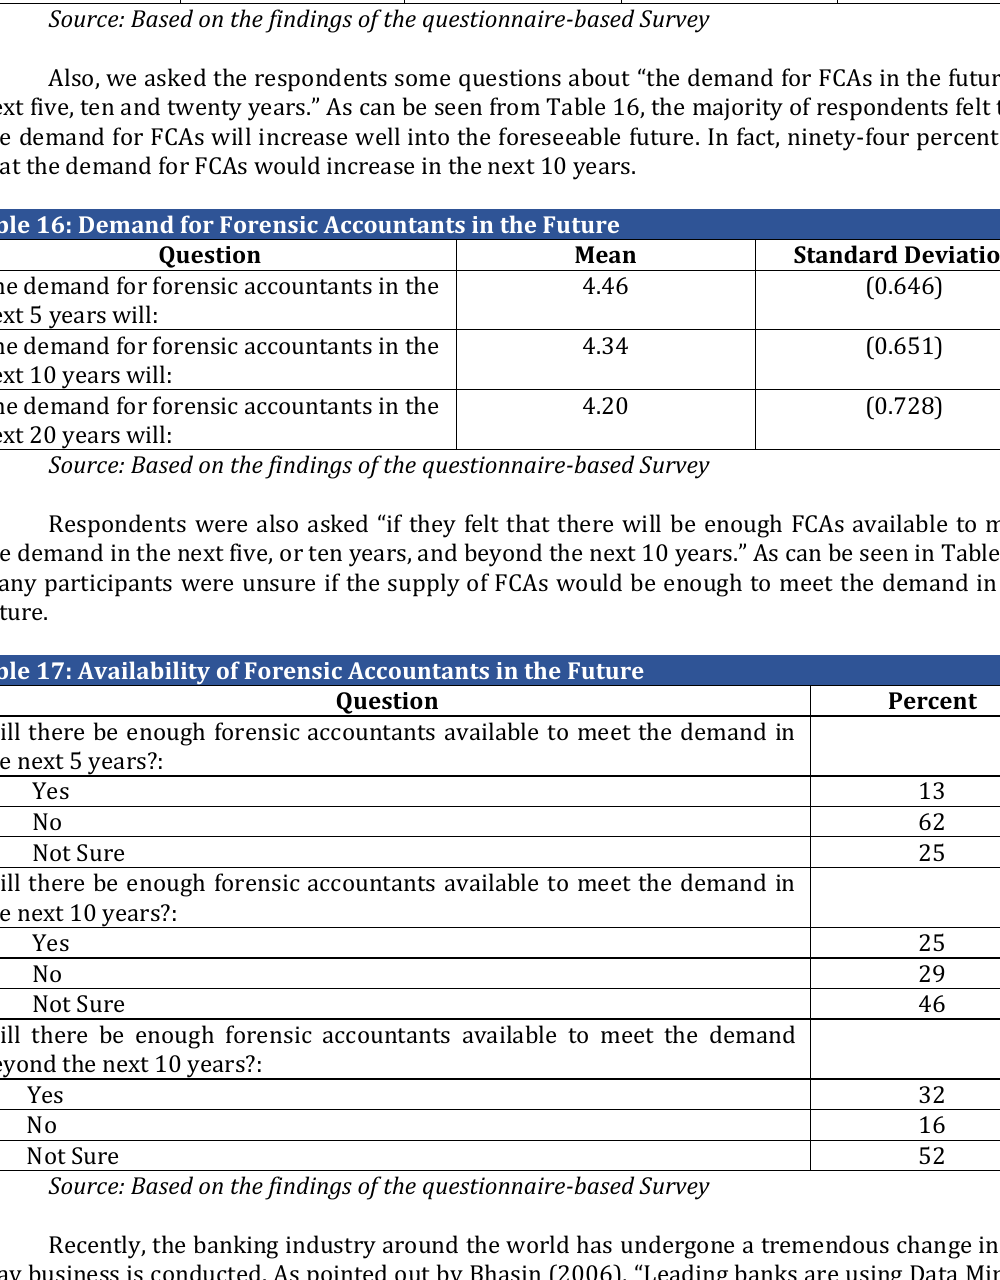
Table 15: Response about New Fraud Trends that will be of Concern in the Next 2 Years ATM Phishing/vishing Mortgage Credit card Others 23% 16% 37%